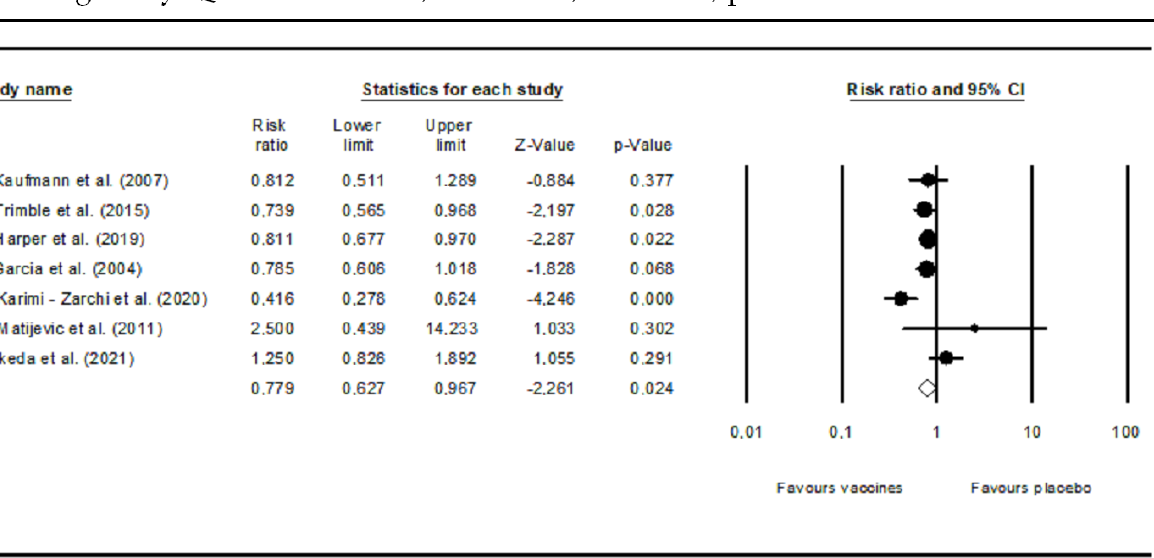
Figure 4. Forest plot of histopathological downgrading results after vaccination compared with placebo. Downgrading was considered an histological improvement to normal or CIN 1.